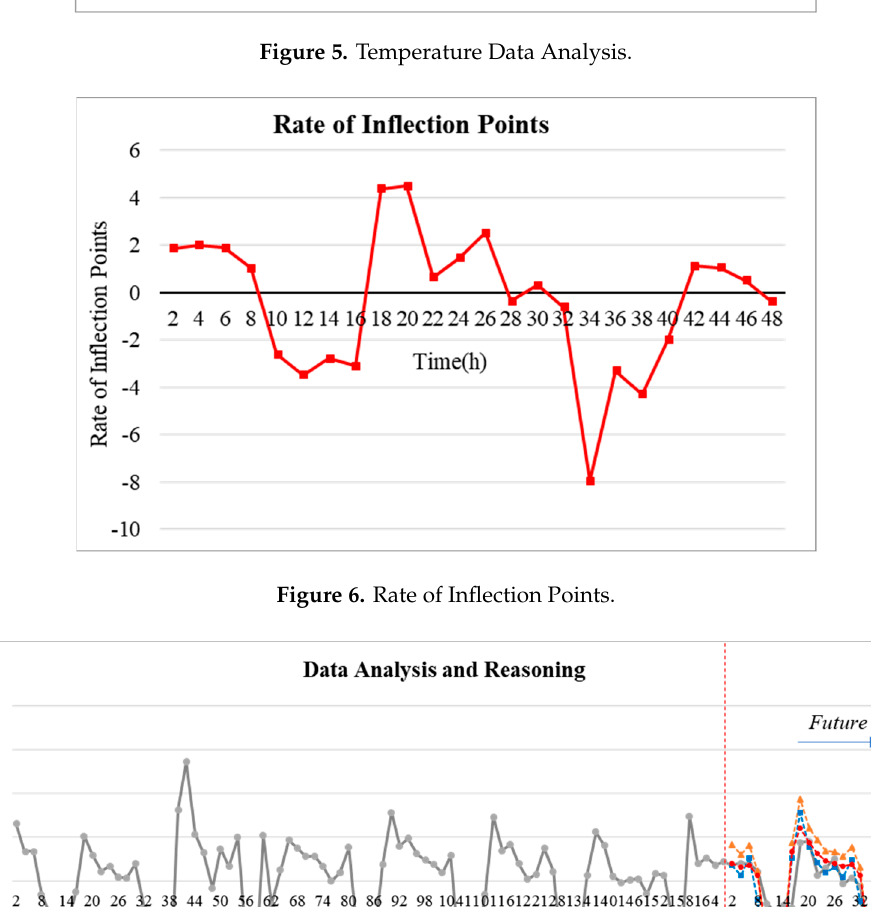
Figure 8. Data Forecasting and Reasoning by ML. Figure 9. Error Rate by MAE (Mean Absolute Error) Method. Figure 5 shows a graph of the internal temperature change of the hotel. The data collection period is 25 November 2019 to 1 December 2019, and it was collected by comparing the room and outdoor temperatures in real time. Only the difference was analyzed for the temperature change trend in the room. The reason for measuring the difference between the indoor and outdoor temperatures is to analyze whether any event occurred in the room. In other words, it is to analyze